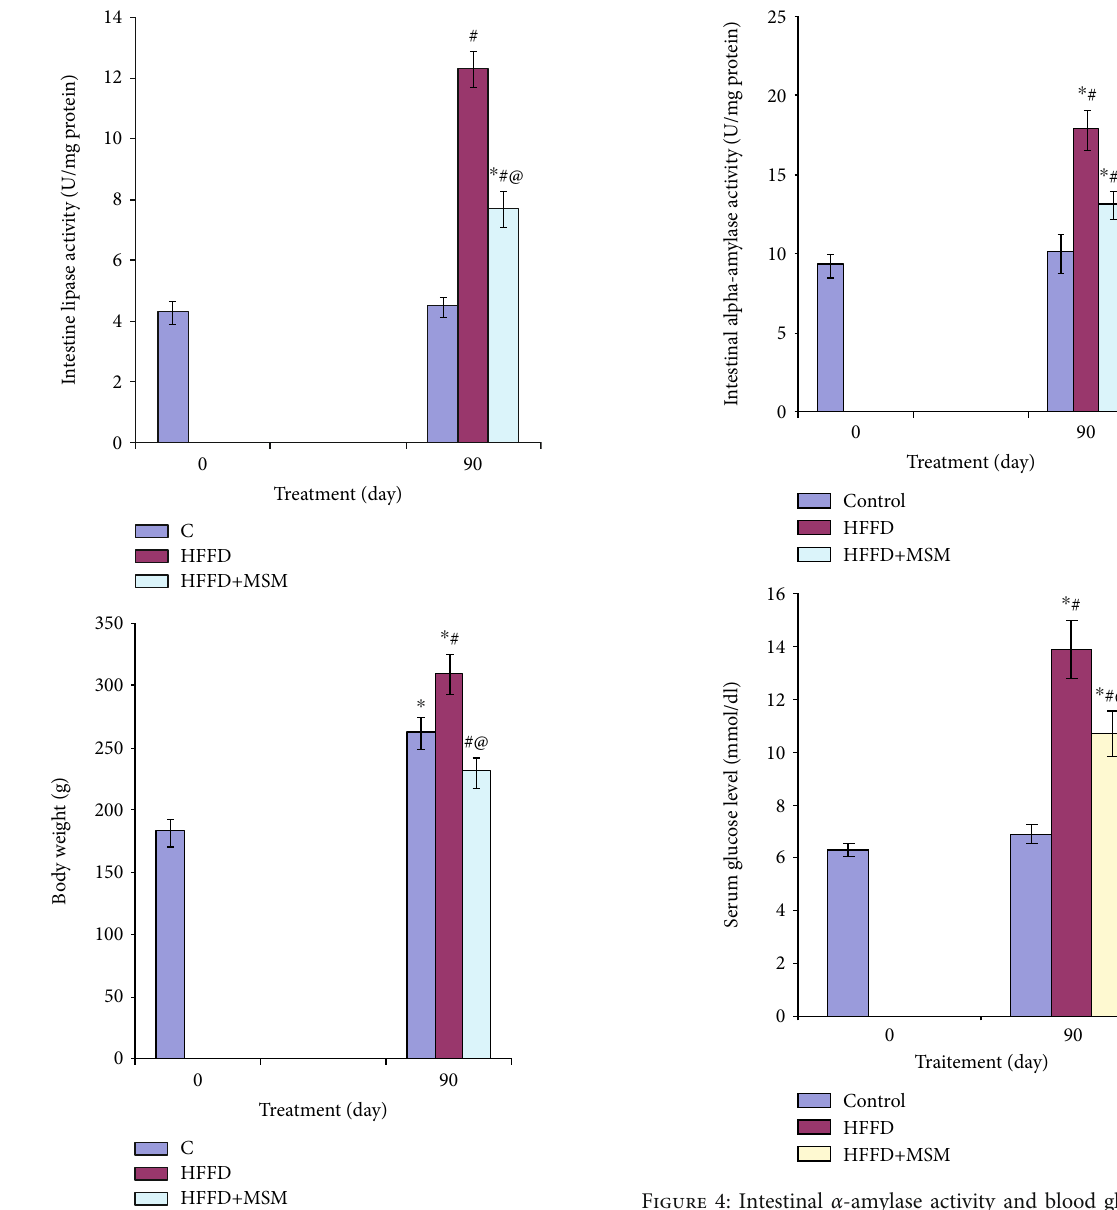
Figure 3: Intestinal lipase activity and body weight in HFFD rats treated with MSM. ∗ P < 0 : 05 signi fi cant di ff erences compared to controls (0 day). # P < 0 : 05 signi fi cant di ff erences compared to controls (90 days). @ P < 0 : 05 signi fi cant di ff erences compared to HFFD rats.